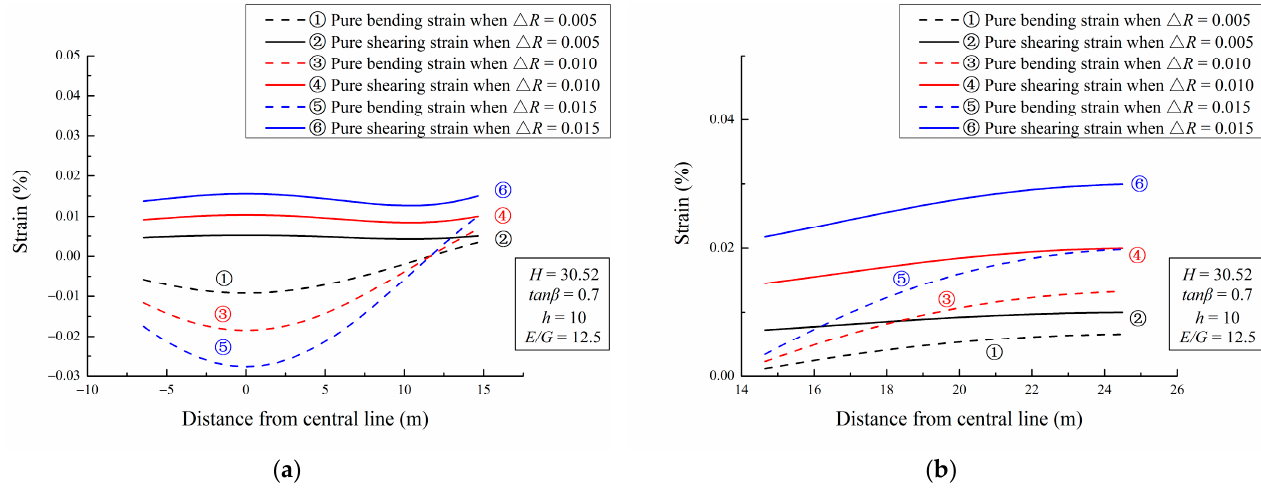
Figure 16. E ff ect of the radius of the tunnel convergence on the tensile strain in ( a ) the sagging zones and ( b ) the hogging zones .